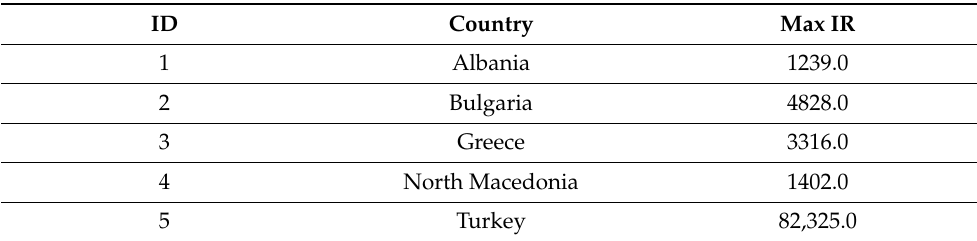
Table 6. Maximum infection